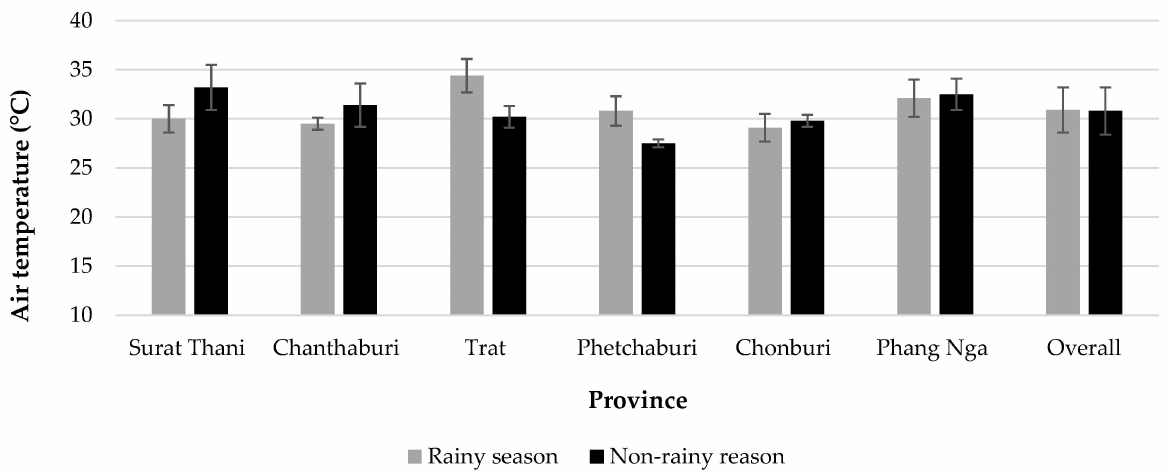
Figure 2. The average temperature during rainy (n = 180) and non-rainy season (n = 183), stratified by province.